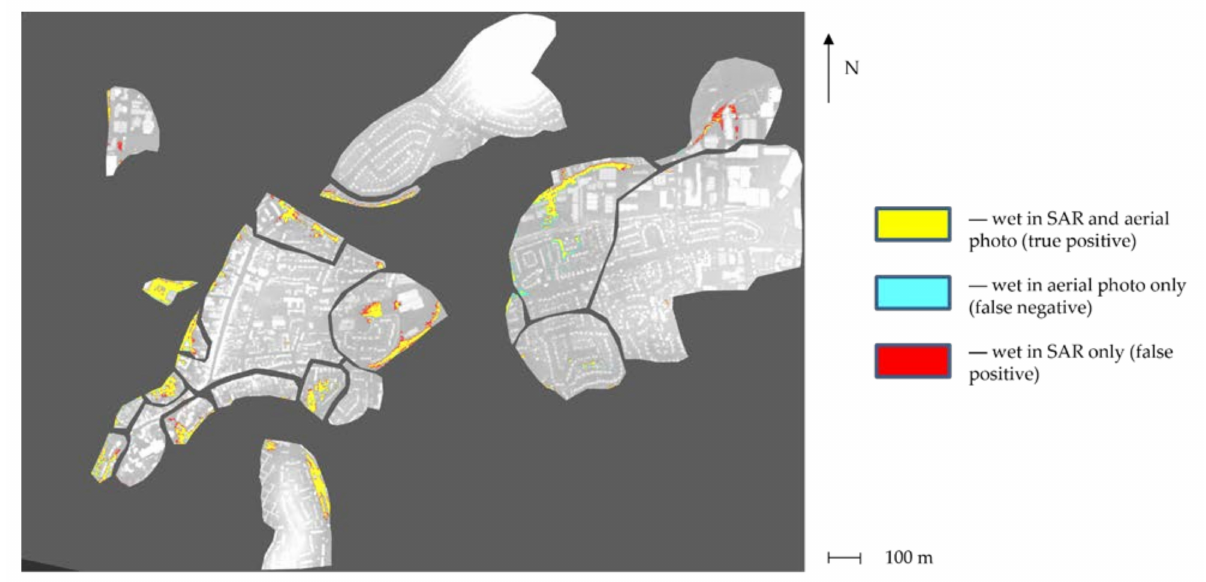
Figure 9. Correspondence between the SAR and aerial photograph flood extents in the urban area of Tewkesbury, superim- posed on the LiDAR image (lighter grey –